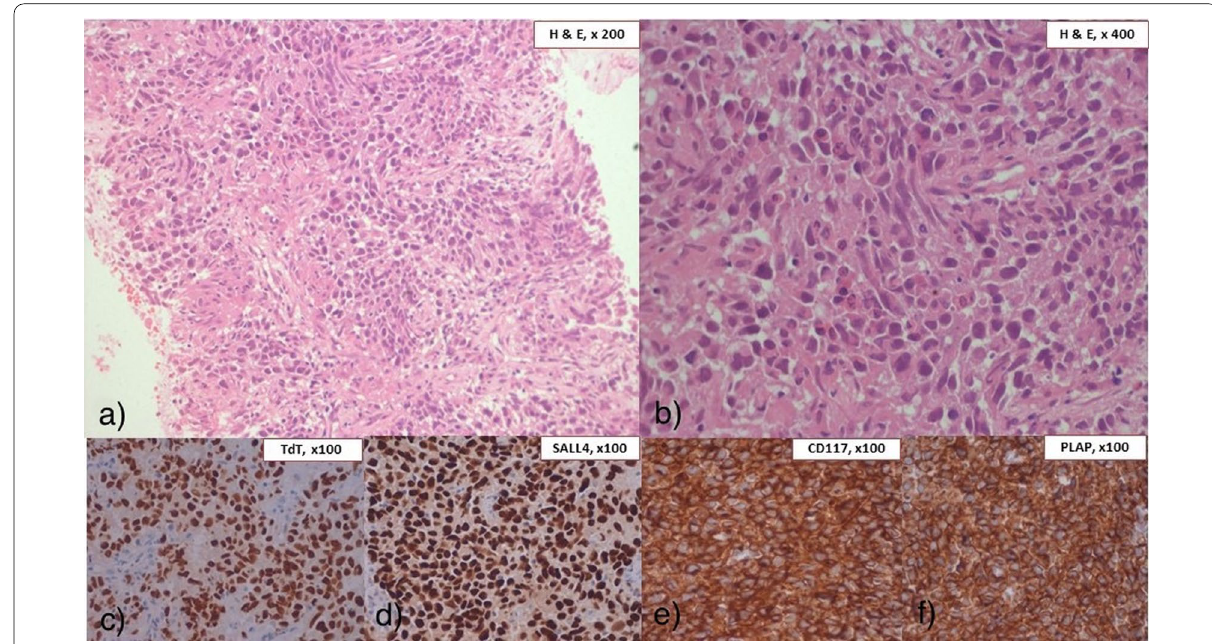
Fig. 3 a The tumor cells are round to polygonal with abundant cytoplasm and some showing an occasional nucleolus, (H&E, 200). b Higher magnification of the same, (H&E, 400). Tumor cells are immunopositive for Tdt c , SALL-4 d , CD117 e and PLAP f